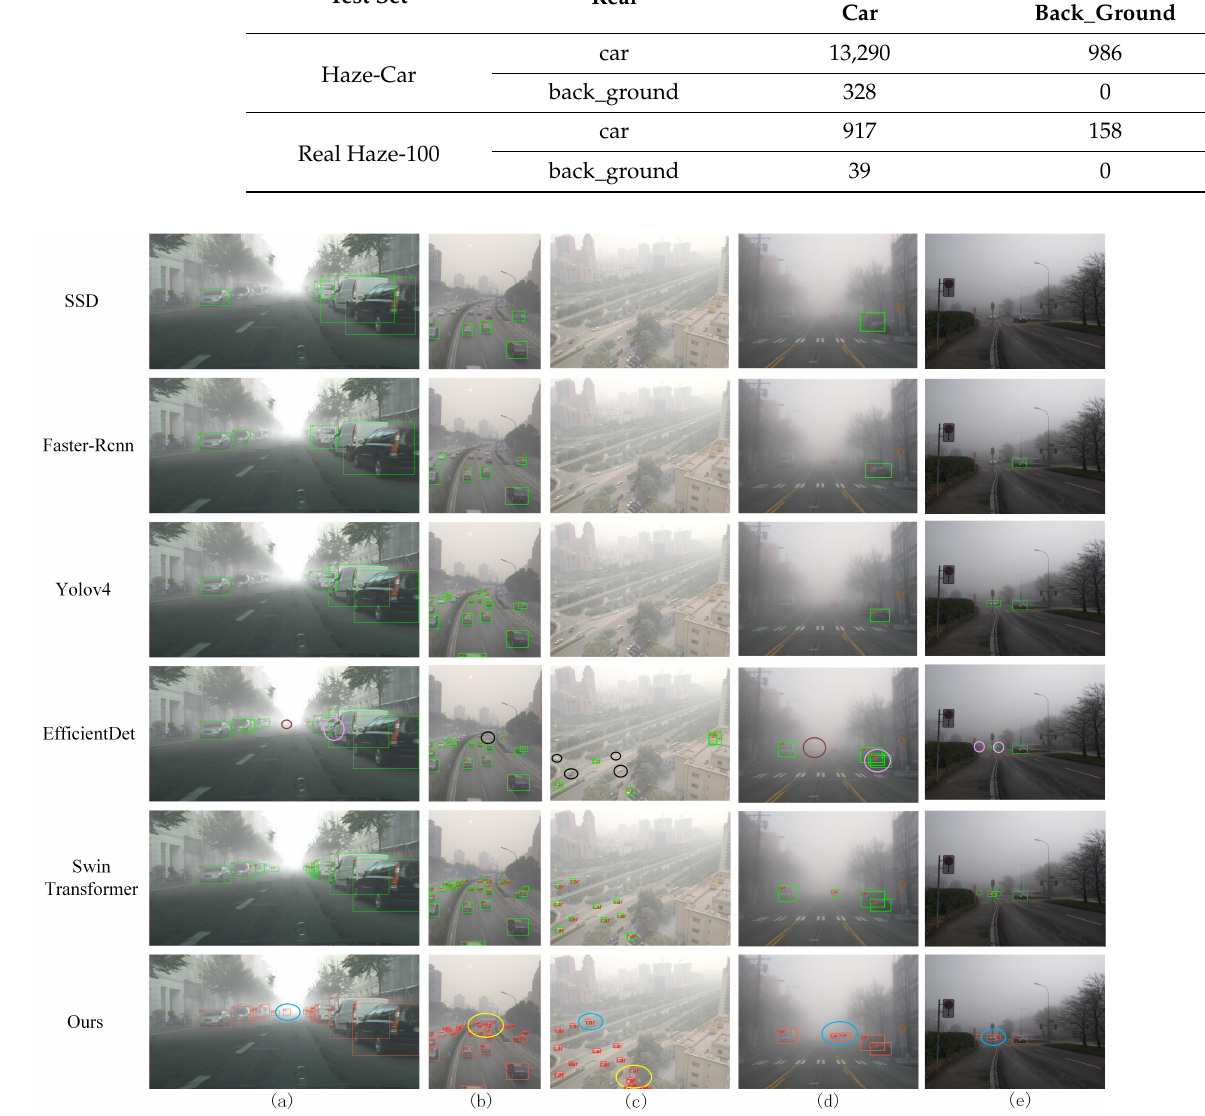
Figure 7. Qualitative comparison of detection results of our method and different algorithm models on the synthetic haze image Haze-Car ( a – c ) and the natural haze image Real Haze-100 ( d , e ).